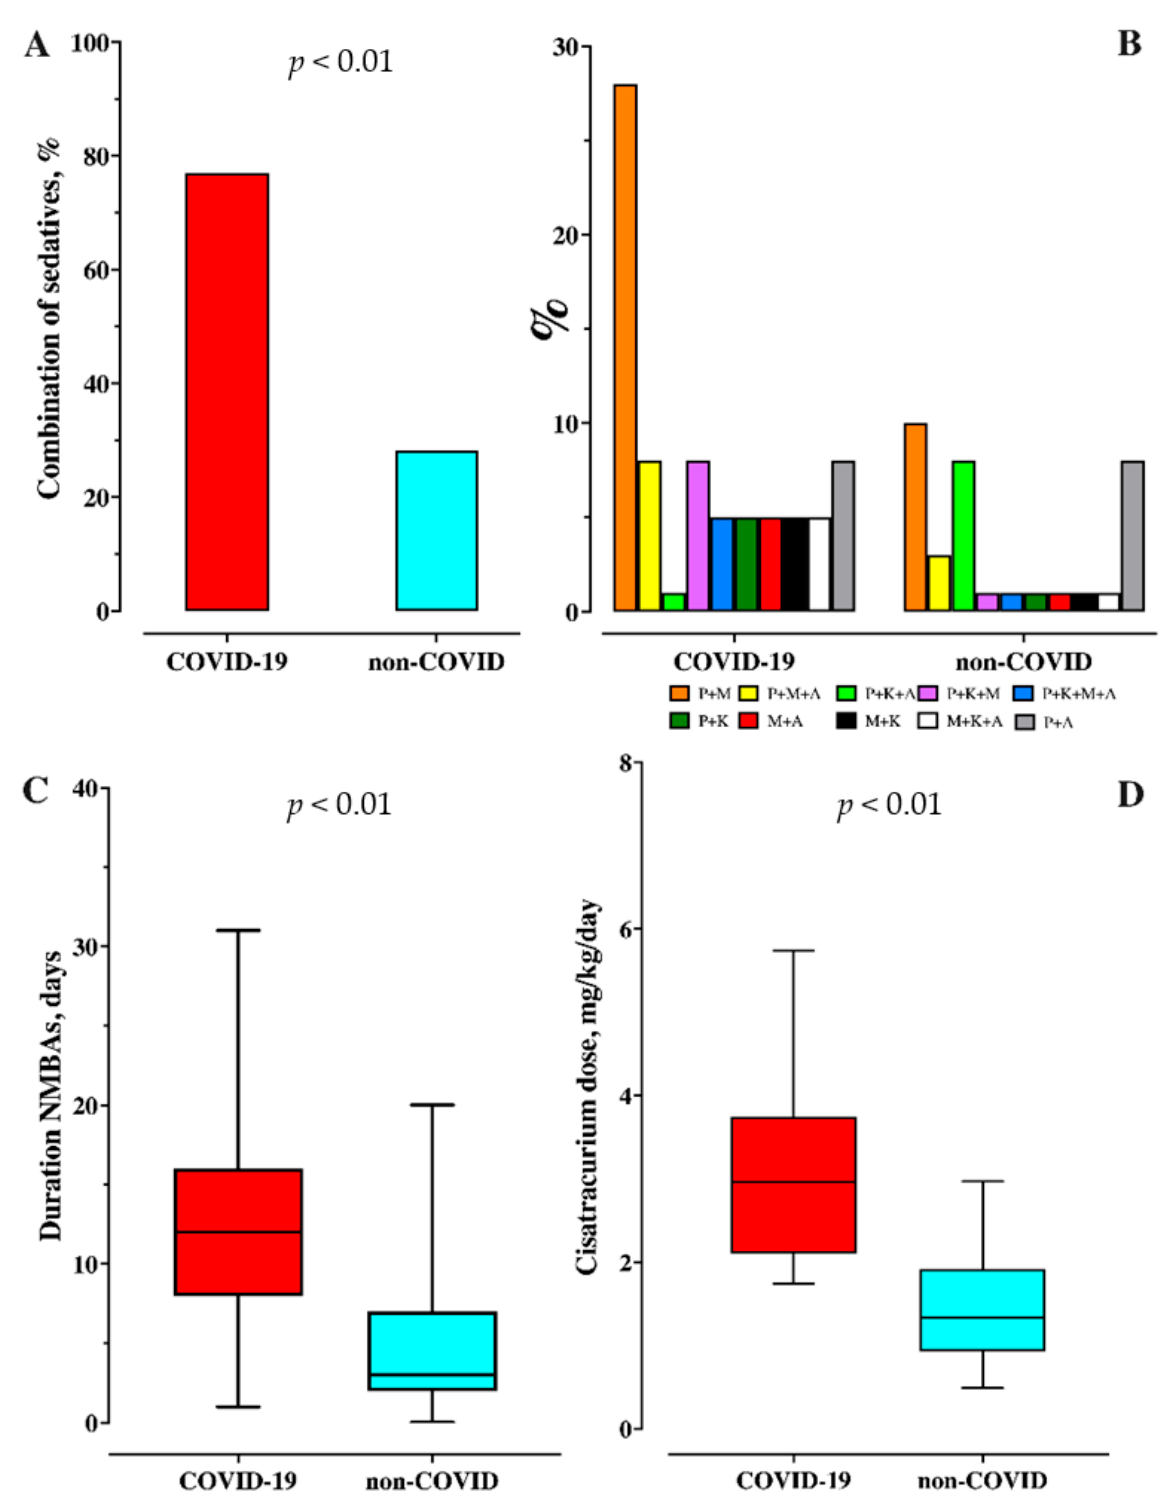
Figure 2. Combination of sedatives, analgesics and neuromuscular-blocking agents. ( A ): Proportion of patients receiving a combination of sedatives. ( B ): Description of the combination of sedatives. ( C ): Duration of administration of Neuromuscular blocking agents (NMBA). ( D ): Cisatracurium administration regimen. P+M = Propofol + midazolam; P+M+A = Propofol + midazolam + alpha-2-agonist; P+K+A = Propofol + ketamine + alpha-2-agonist; P+K+M = Propofol + ketamine + midazolam; P+K+M+A = Propofol + ketamine + midazolam + alpha-2-agonist; Propofol + ketamine; M+A = Midazolam + alpha-2-agonist; M+K = Midazolam + ketamine; M+K+A = Midazolam + ketamine + alpha-2-agonist; P+A = Propofol +